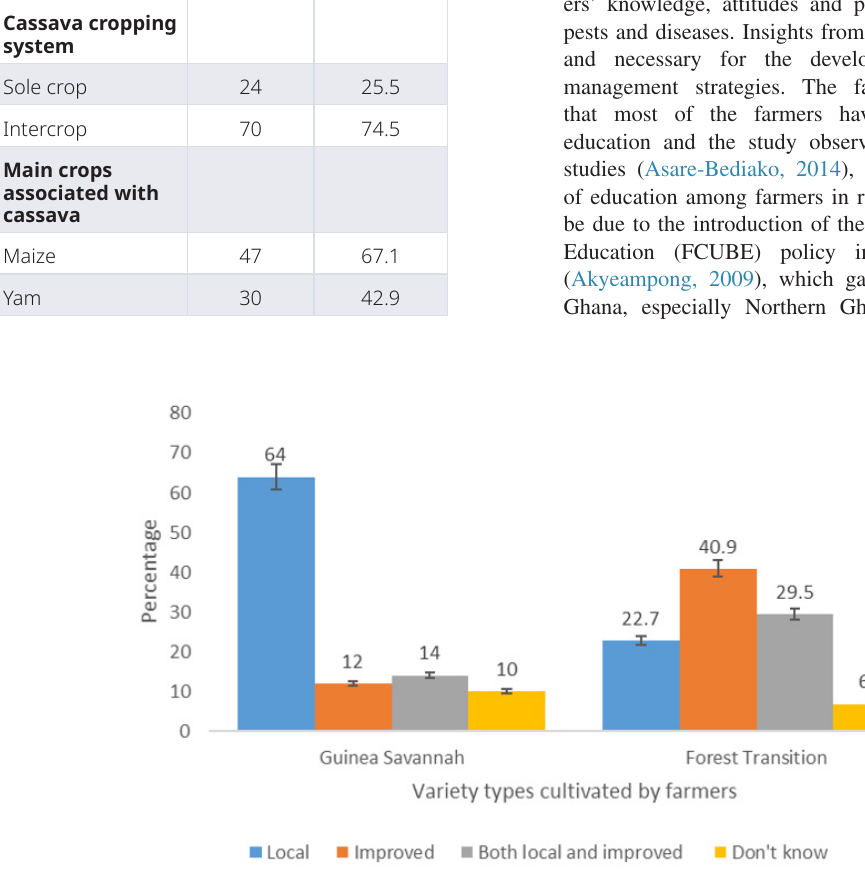
Figure 2. Graph of variety types cultivated by